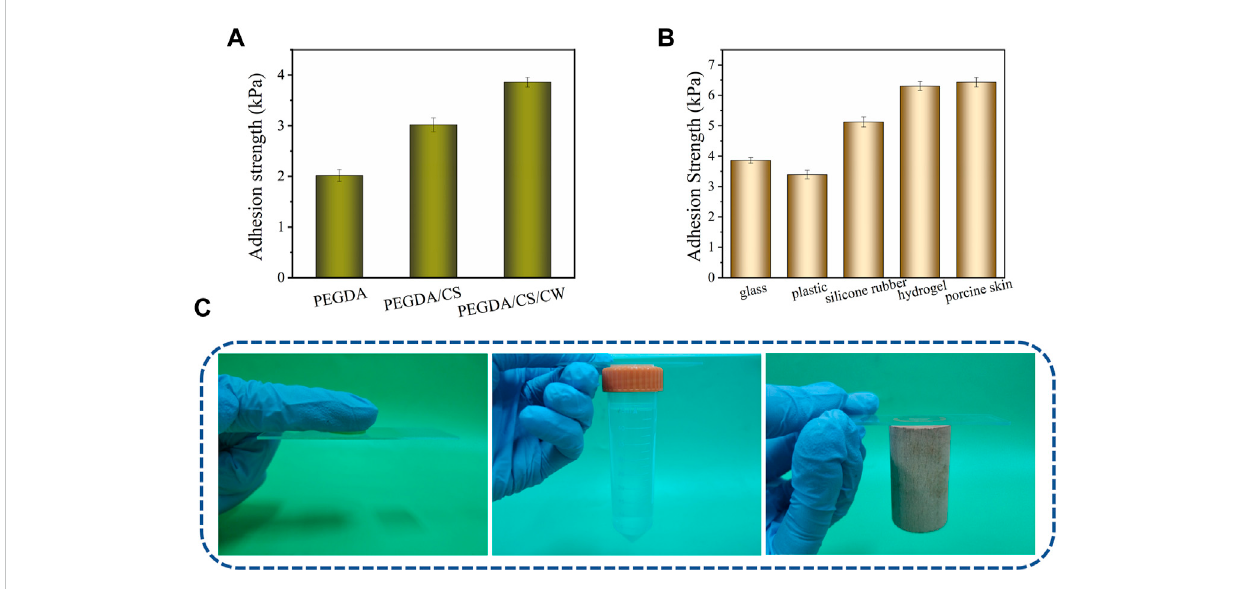
FIGURE 4 (A) Adhesion strength between hydrogel of different components and glass sheets. (B) PEGDA/CS/CW hydrogel adhesion strength to various materials. (C) PEGDA/CS/CW hydrogel adhesion to nitrile glove, plastic and